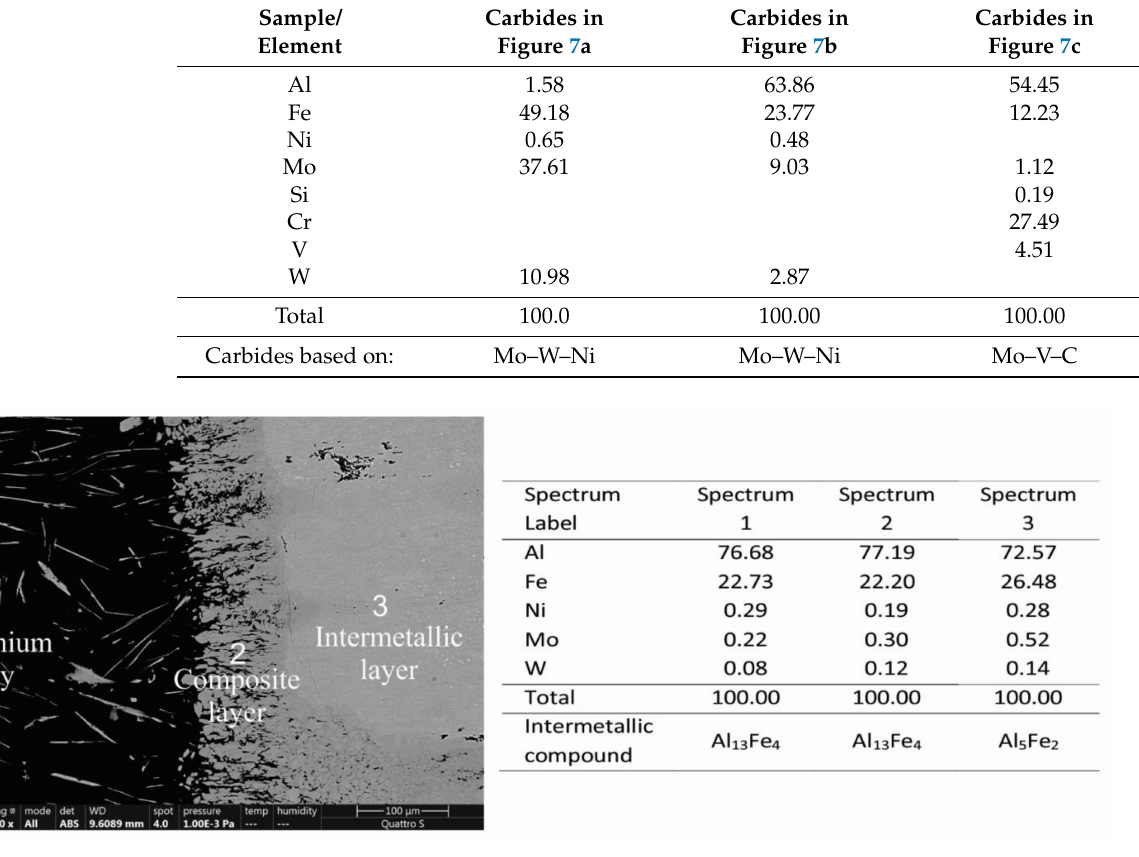
Figure 5. SEM micrographs of the interaction layer of the HTCS-130 sample tested at 700 ◦ C in Al99.7 aluminum alloy. The corresponding EDS results are presented in at